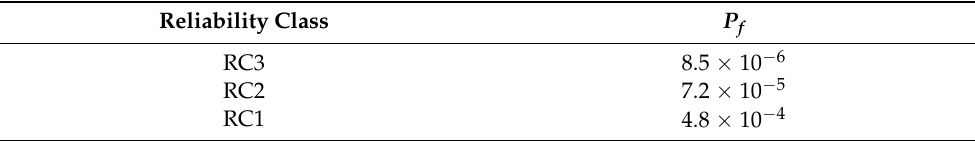
Table 3. The target values of failure probability P f according to